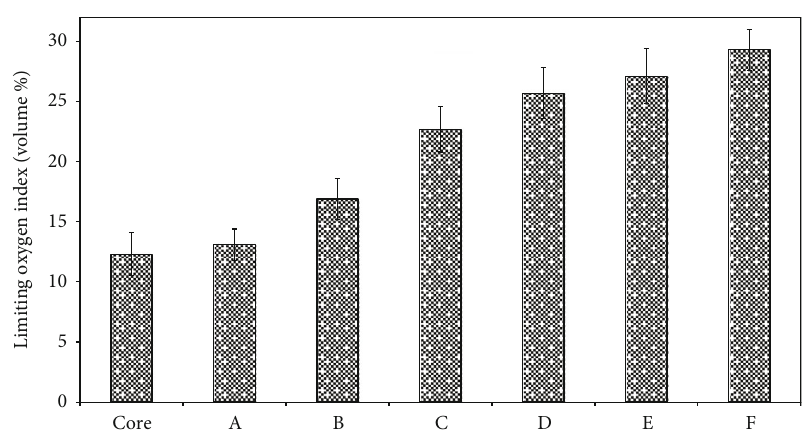
Figure 5: LOI of coextruded WPC with a talc- fi lled shell.